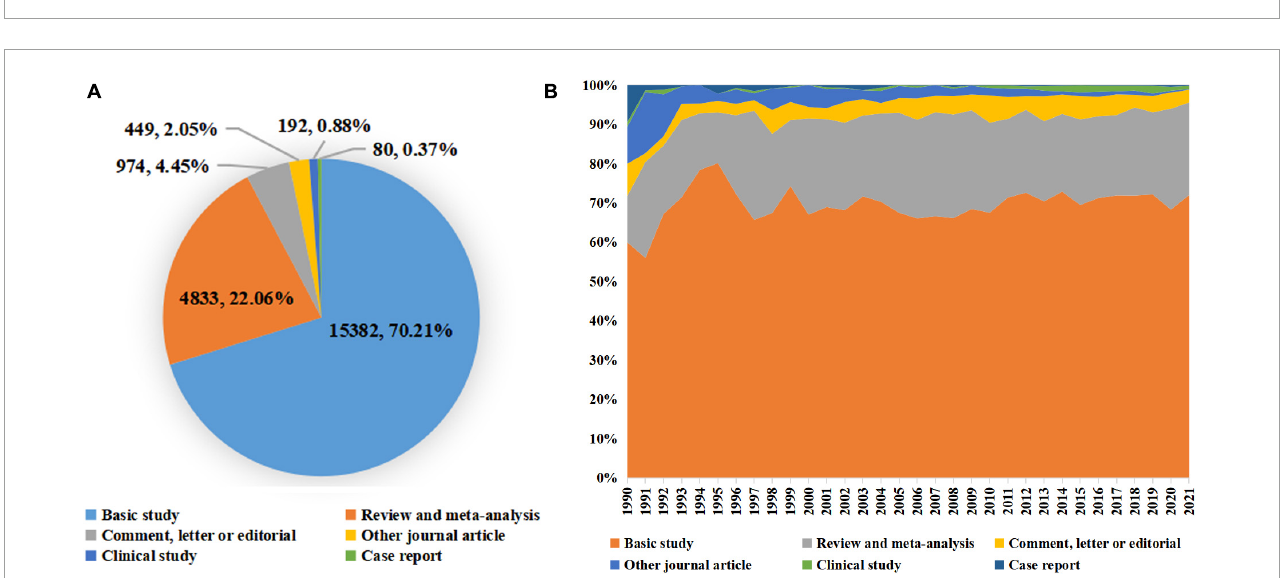
were the top two terms over the past three decades and remained popular until 2021. Additionally, the MeSH term telomere shortening